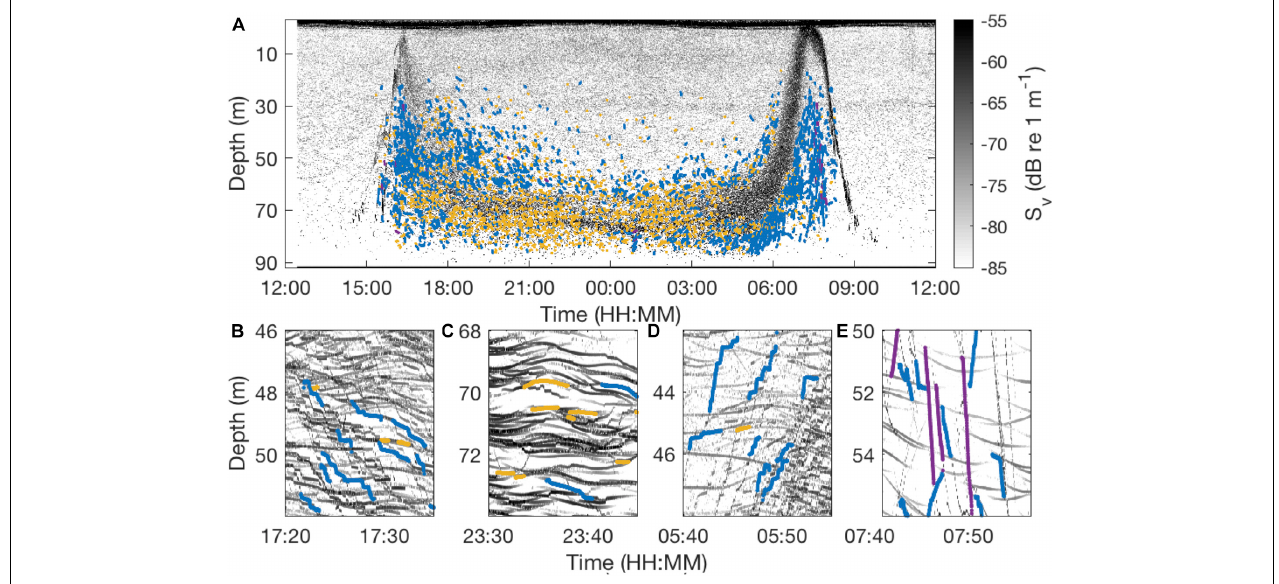
FIGURE 6 | Echogram from January 22, 2011 recorded with a 200 kHz EK60 Echosounder (A) and zoomed into 15-min snapshots representing different periods of nocturnal behavior: the dusk descent (B) , the middle of the night (C) , the dawn ascent (D) , and the dawn descent (E) . Tracks representing different types of behaviors are depicted in colored lines with blue lines indicating step-wise swimming, yellow lines stationary behavior and purple lines direct ascents/descents.